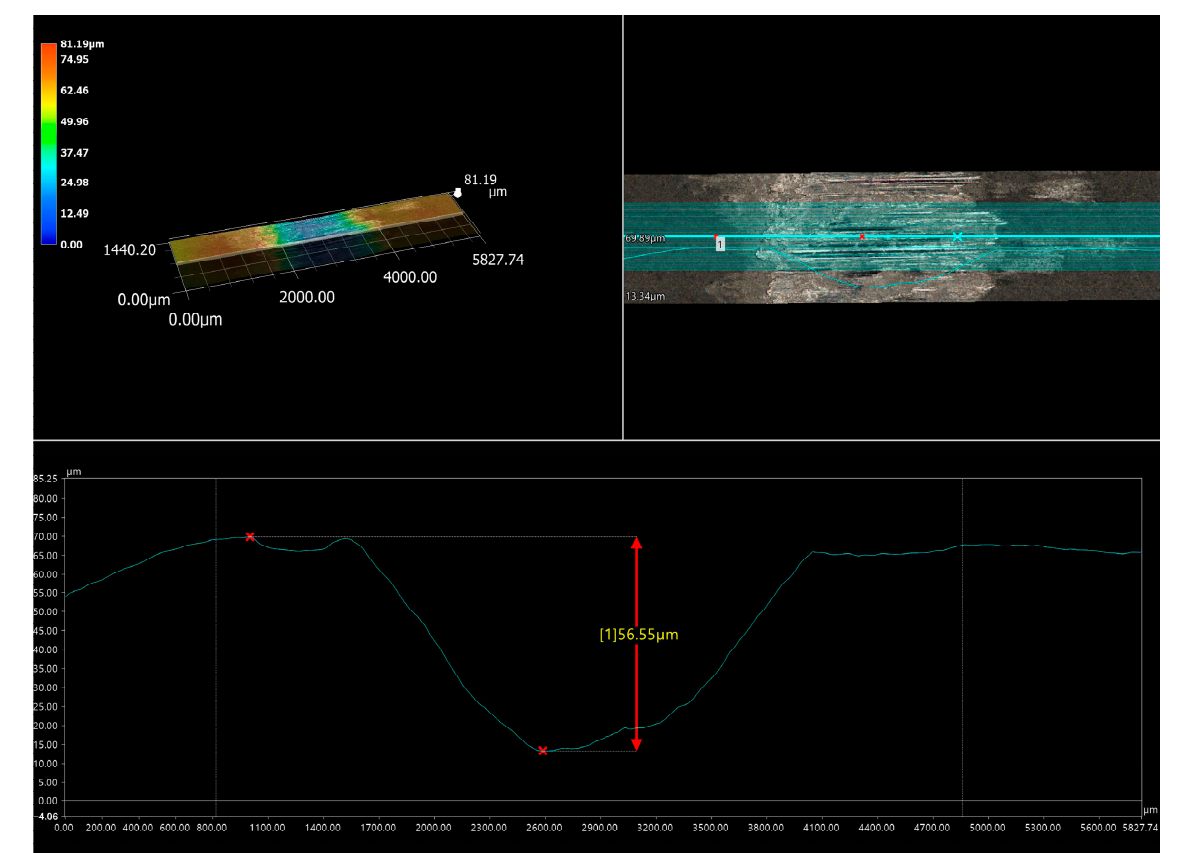
Figure 19. The cross-section of the 3D image of the surface topography and the 2D profile across the worn track formed on the surface of the counter-specimen mating with specimen laser-alloyed with a laser beam power of 1.3 kW; 1—measuring point of the depth of the worn track in relation to the nominal surface of the counter-specimen.